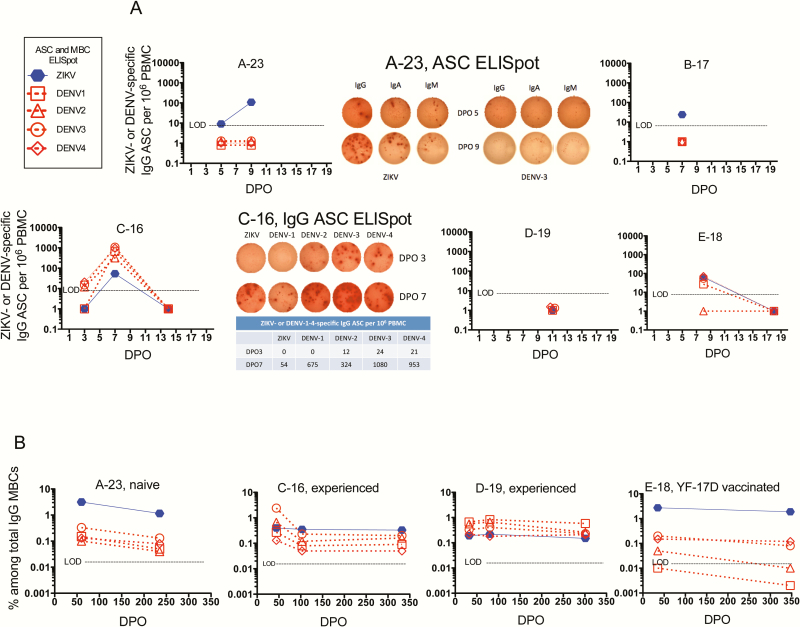
Enzyme-Linked ImmunoSpot (ELISpot) assays for Zika virus (ZIKV)– and dengue virus (DENV)–specific antibody-secreting cells (ASCs) and memory B cells (MBCs). A, Antigen-specific ASCs were quantitated using fresh peripheral blood mononuclear cells (PBMCs). For patient A-23, 3 isotypes of ZIKV-specific immunoglobulin (Ig; M, A, and G) were detected in this flavivirus-naive patient (and for patient B-17, also flavivirus-naive). In contrast, for patient C-16 (flavivirus-experienced), only IgG-secreting ASCs were detected; also true of patient E-18 (also flavivirus-experienced). B, MBCs against ZIKV or DENV were detected in thawed PBMCs. In these assays absolute levels of ZIKV-specific vs DENV-specific ASCs or MBCs cannot be directly compared since the ZIKV antigen was viral lysate and the DENV antigens were recombinant E proteins. Abbreviations: ASC, antibody-secreting cells; DENV, dengue virus; DPO, days post onset of symptoms; Ig, immunoglobulin; LOD, limit of detection; MBC, memory B cell; PBMC, peripheral blood mononuclear cell; ZIKV, Zika virus.